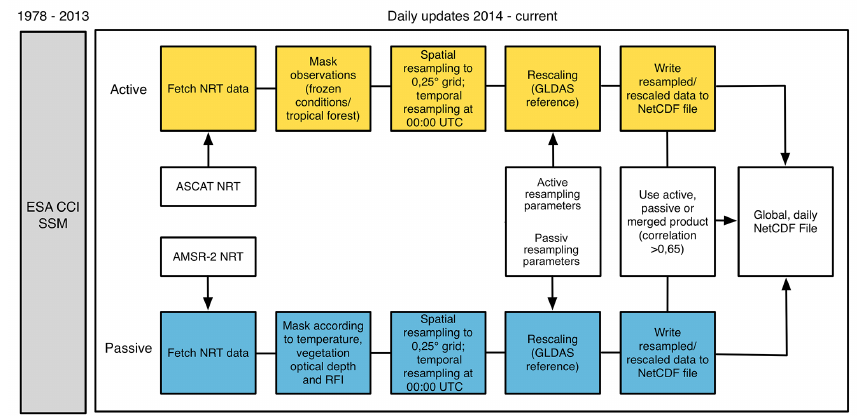
Figure 3. Schematic flowchart illustrating the methodology for extending the ESA CCI SM dataset via NRT observations from ASCAT and AMSR2. The GLDAS-Noah dataset is used as a scaling